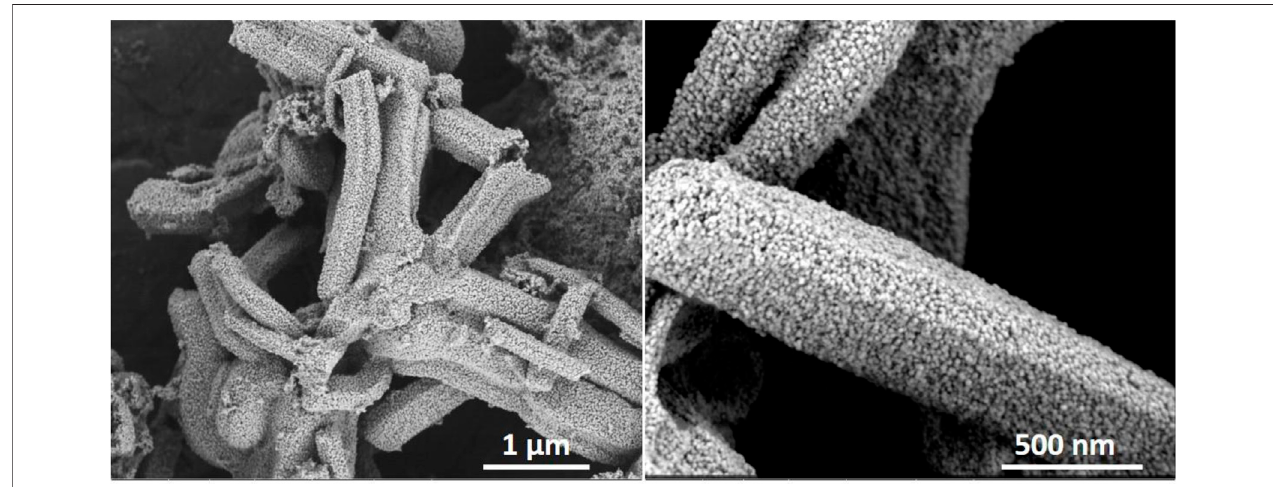
FIGURE 11 | Free-standing Pt replicas of zeotile-4 obtained after silica digestion of zeotile-4 using HF, material discussed in Pulinthanathu Sree et al. (2017).